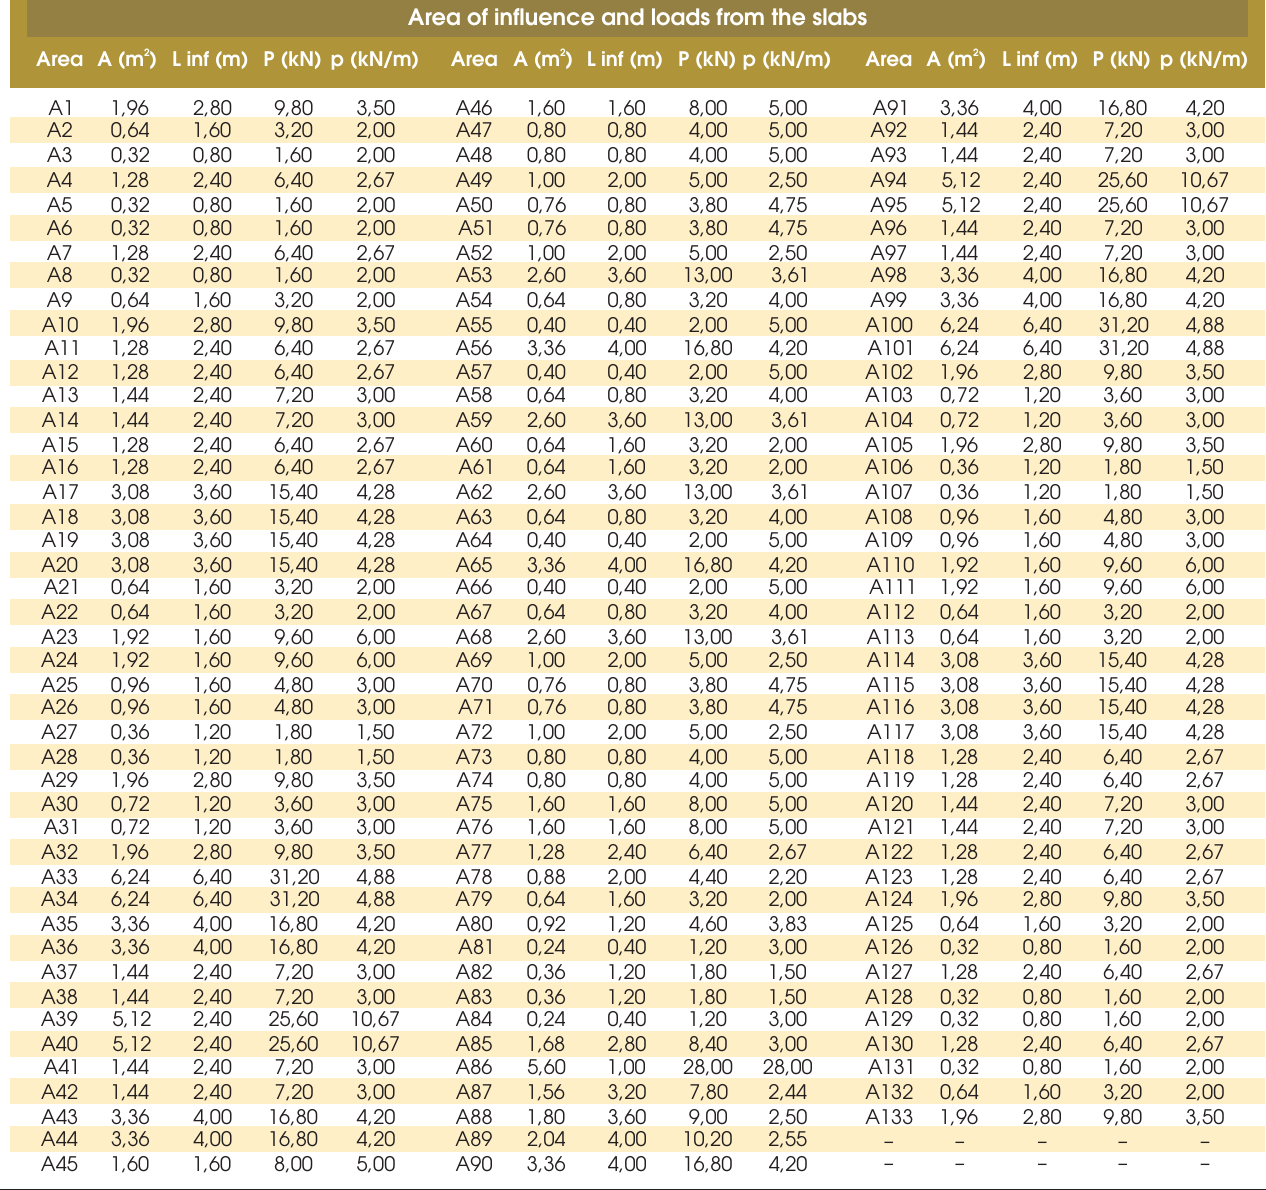
Area of influence and loads from the